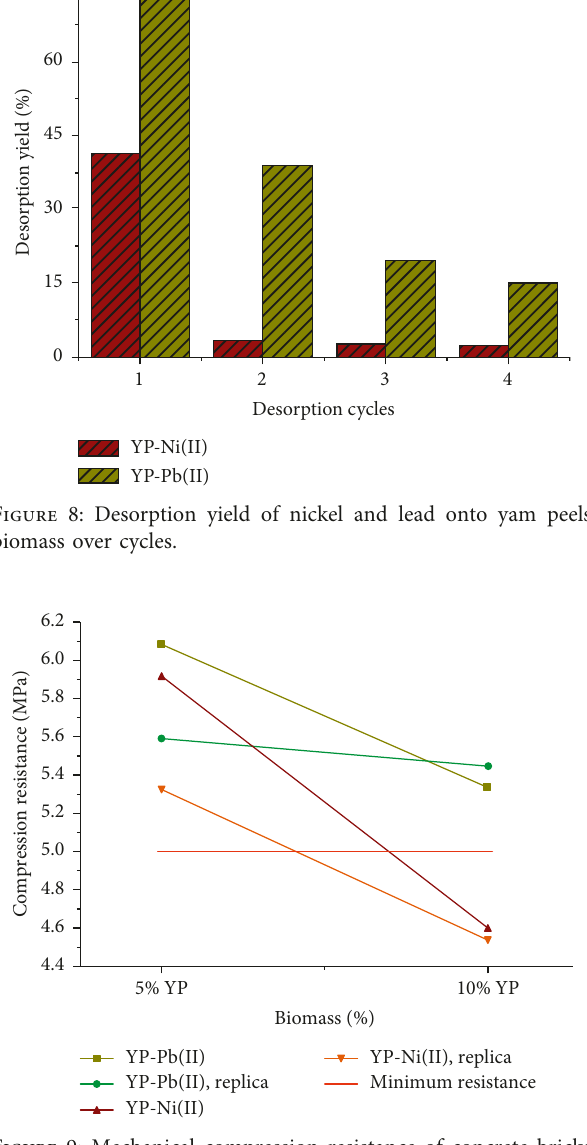
Figure 9: Mechanical compression resistance of concrete bricks with polluted biomass.